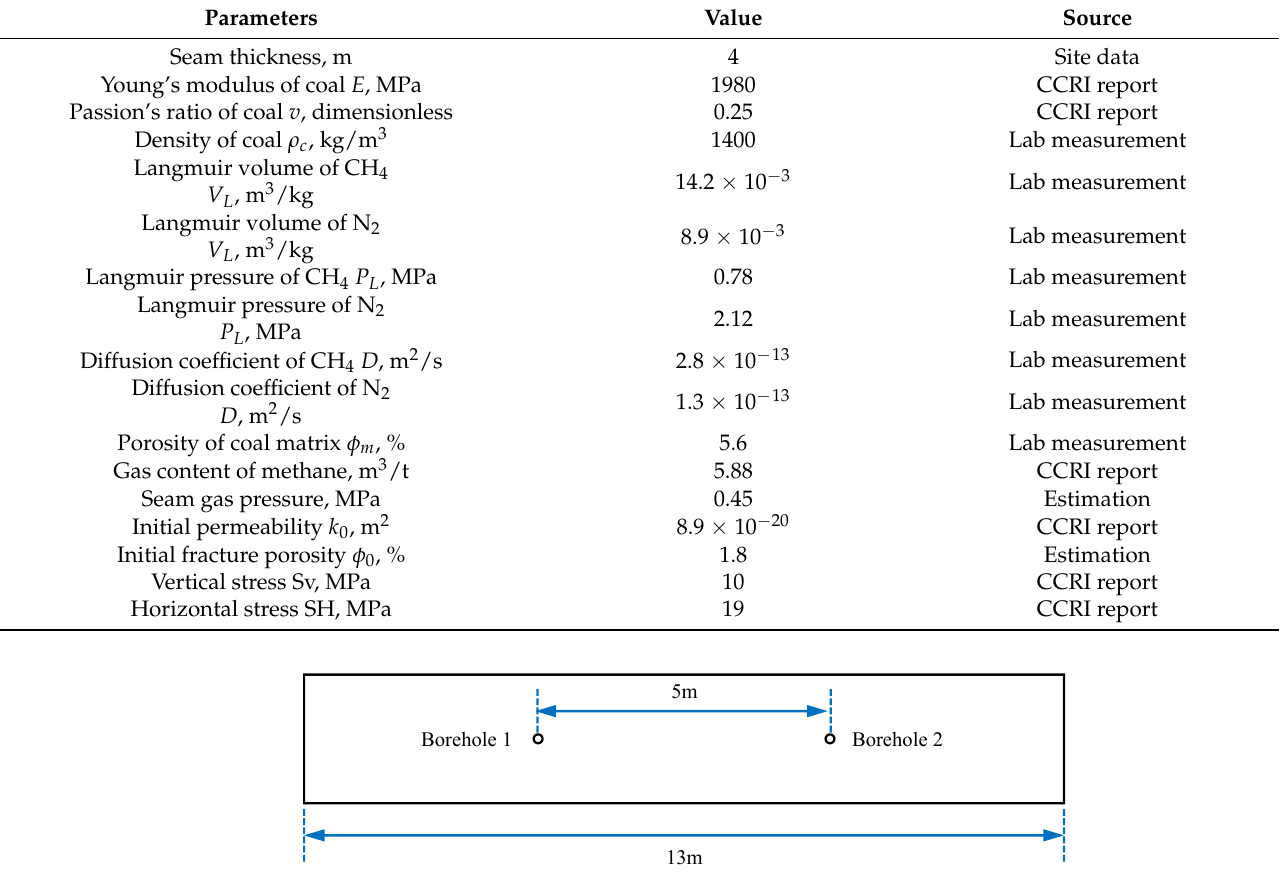
Figure 4. Configuration of the seam and drainage borehole .